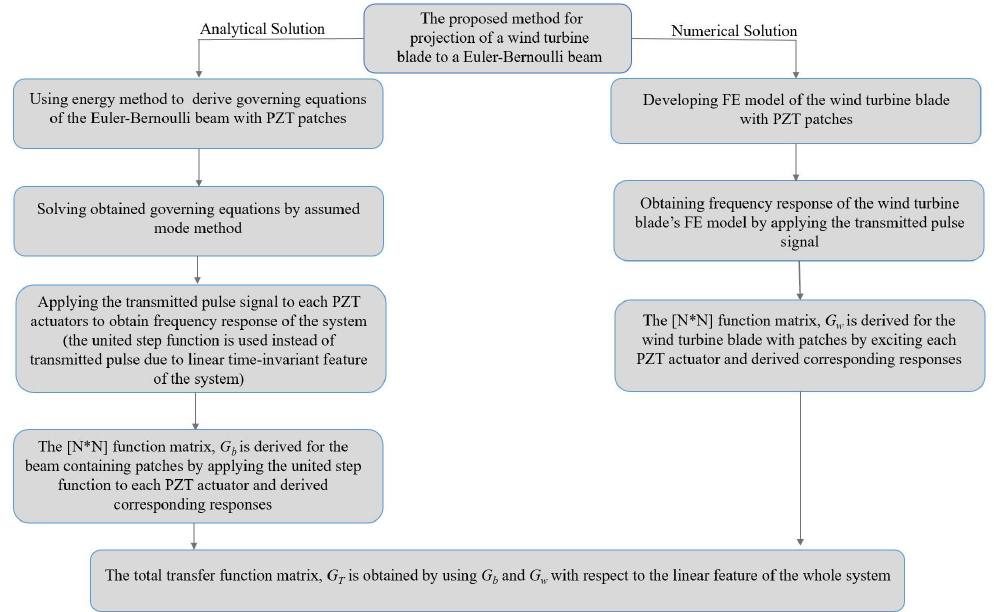
Figure 3. Flow chart of the total transfer function deriving